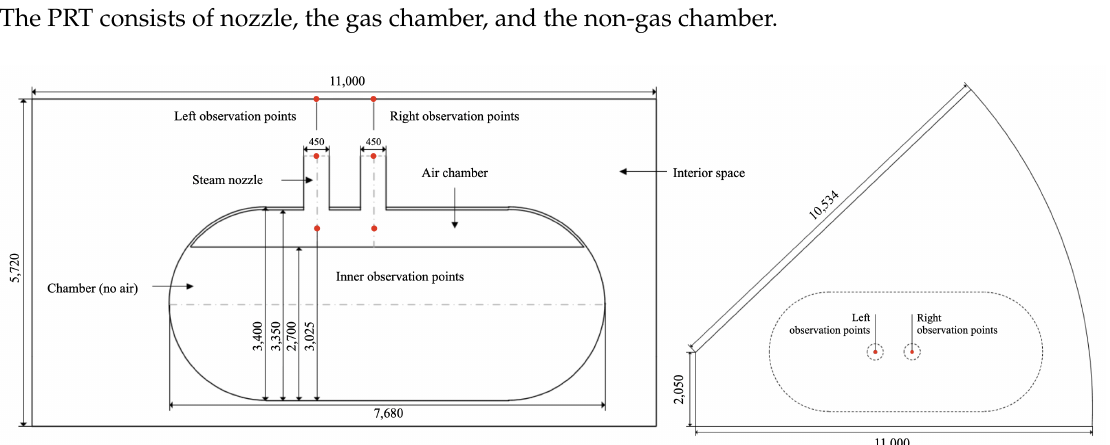
Figure 2. Front and top views of the computational domain of the pressurizer relief tank (PRT) steam dumping process (all geometric parameters are in mm) [12]. There are 6 sampling points in the figure, 3 on the left and 3 on the right, which are, respectively, located inside the PRT, at the nozzle, and at the top of the shell. These points are represented by symbols as Lp-top, Lp-nozzle, Lp-inner, Rp-top, Rp-nozzle, and